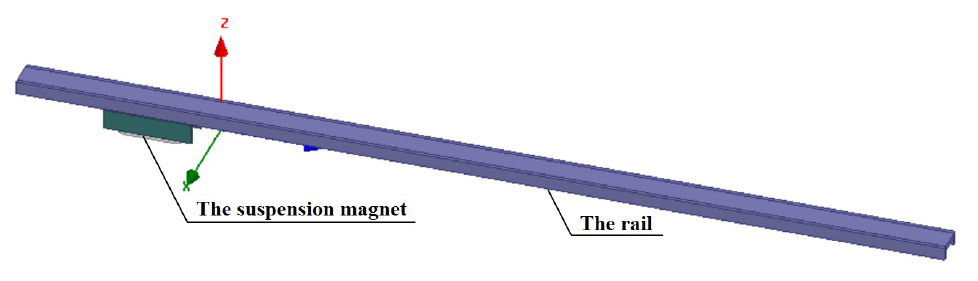
Figure 14. 3D overview diagram of simulation